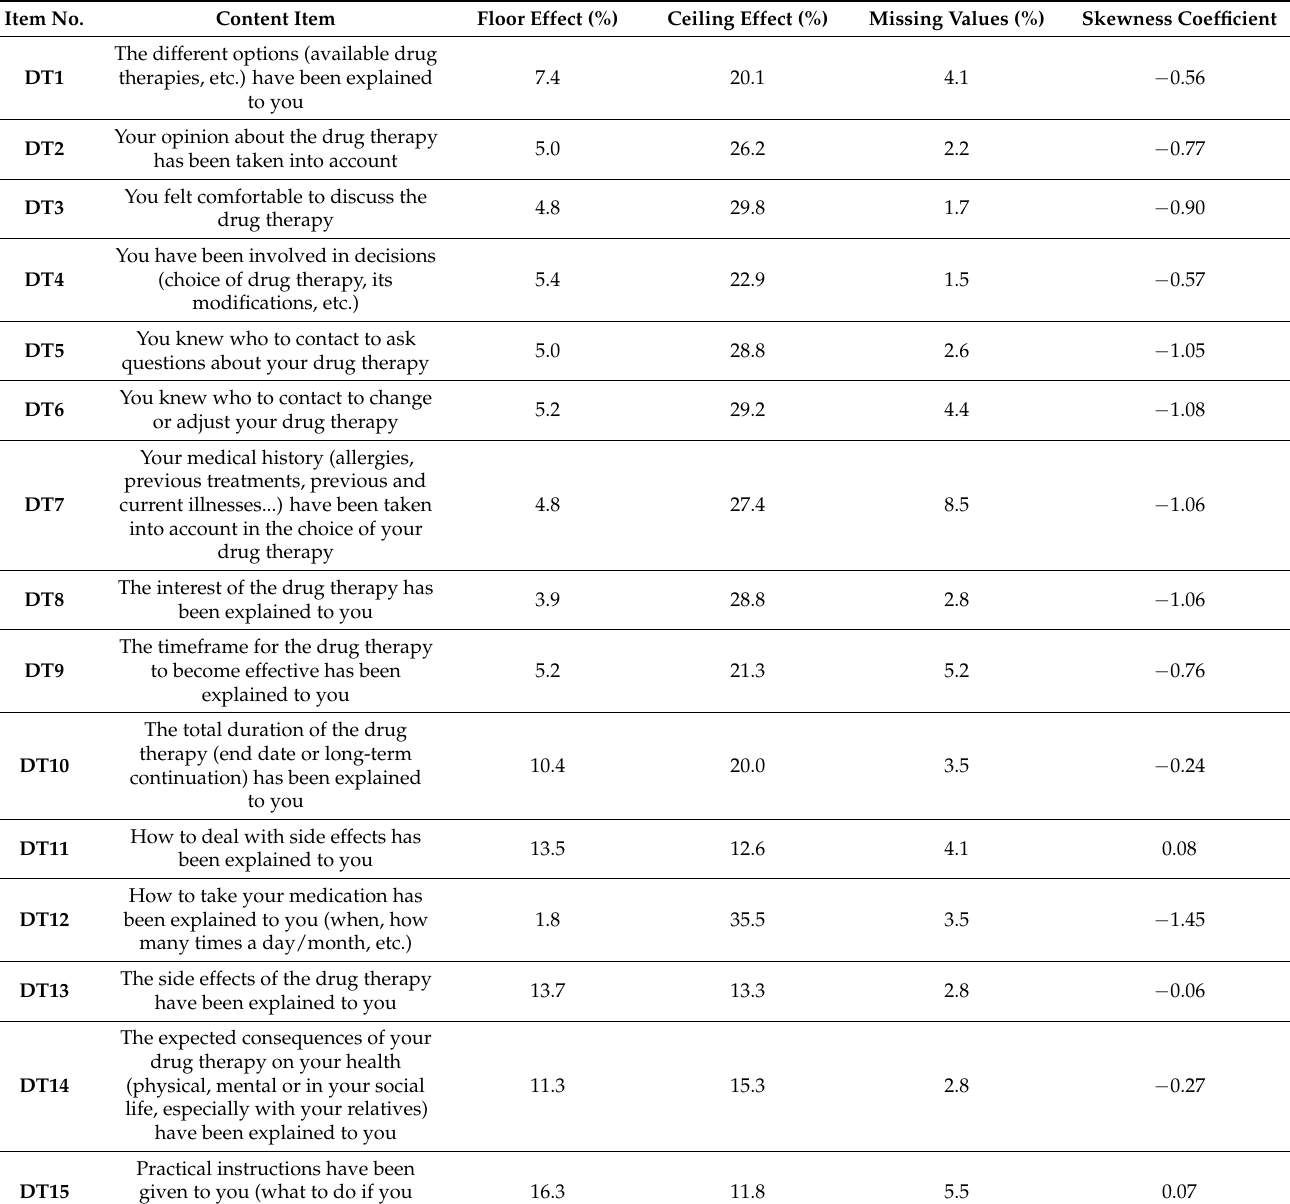
Table 2. Descriptive analysis of the PREMIUM-DT item